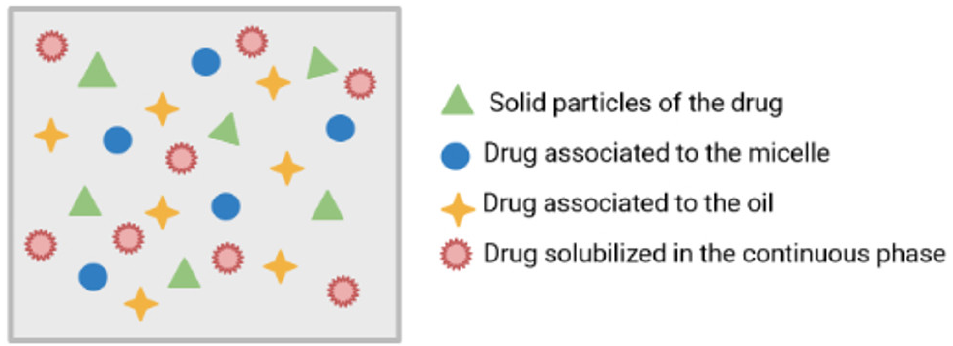
Figure 7. Schematic representation of the formation of phospholipid micelles, showing the different behaviors of drugs [own drawing].